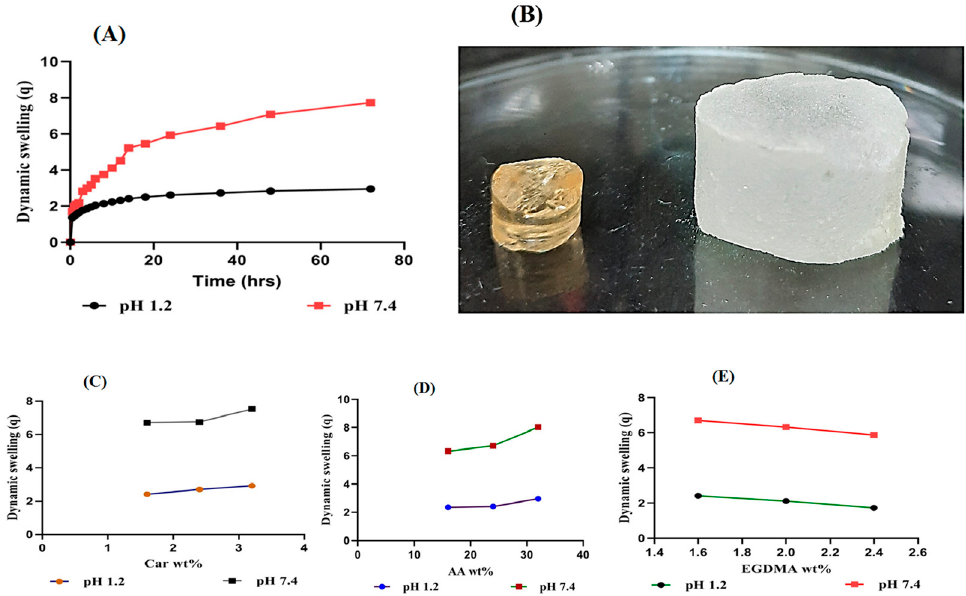
Figure 6. ( A ) E ff ect of pH on dynamic swelling. ( B ) Dried and swelled forms of the Car934-g-poly(acrylic Figure 6. ( A ) Effect of pH on dynamic swelling. ( B ) Dried and swelled forms of the acid) hydrogels. ( C ) E ff ects of carbopol, ( D ) E ff ects of AA and ( E ) EGDMA on the dynamic swelling of Car934-g-poly(acrylic acid) hydrogels. ( C ) Effects of carbopol, ( D ) Effects of AA and ( E ) EGDMA on the Car934-g-poly(acrylic acid) the dynamic swelling of the Car934-g-poly(acrylic acid) hydrogels.